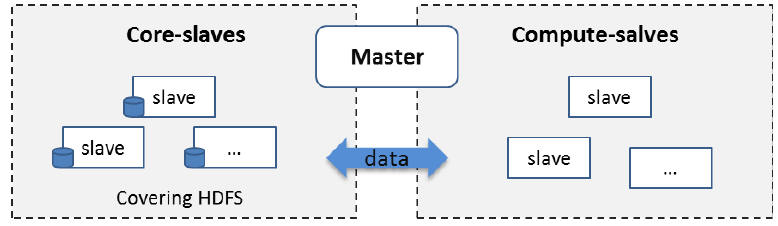
Figure 2. The structure of the cloud-based Hadoop cluster with CoveringHDFS.